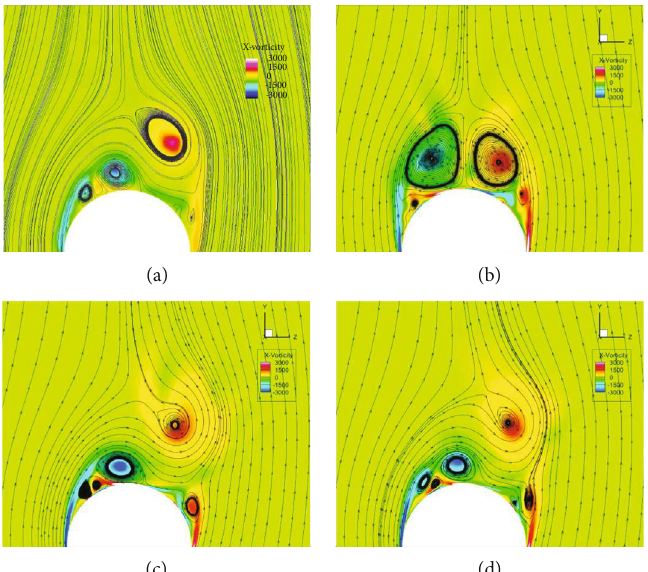
Figure 11: X -vorticity contour comparison at section 3 (a) PIV experiment, (b) result of Grid 1, (c) result of Grid 2, and (d) result of Grid 3.